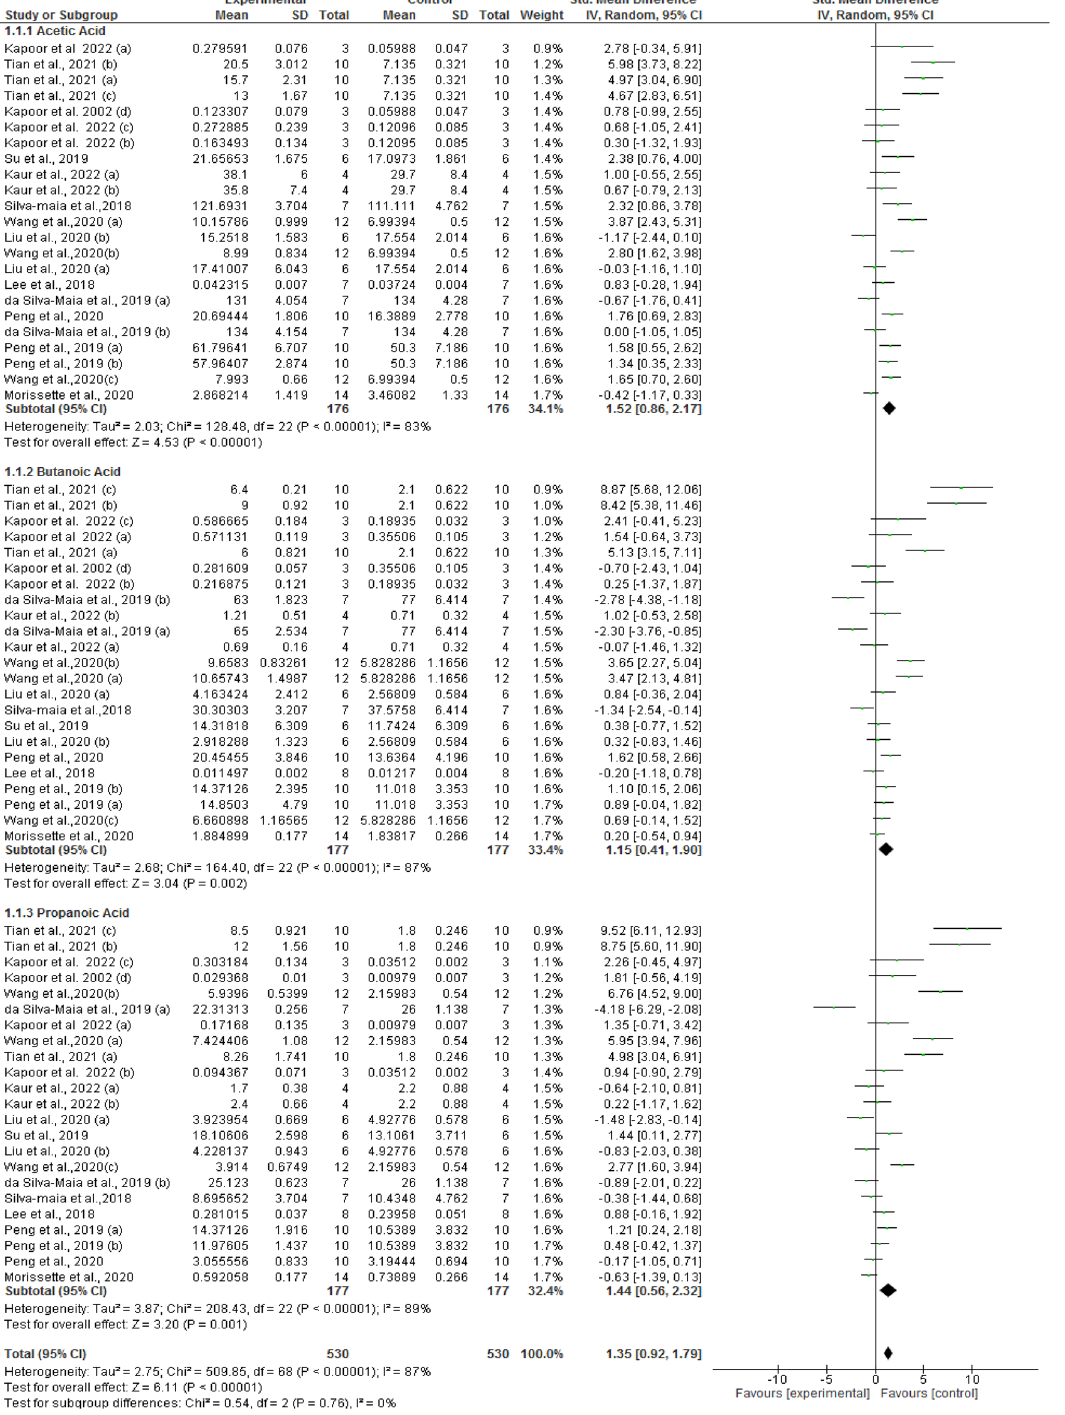
Several studies have shown that obesity is associated with the gut microbiome, which differs between obese and lean animals. The gut health biomarker Fir/ Bac ratio is relevant in human gut microbiota composition.